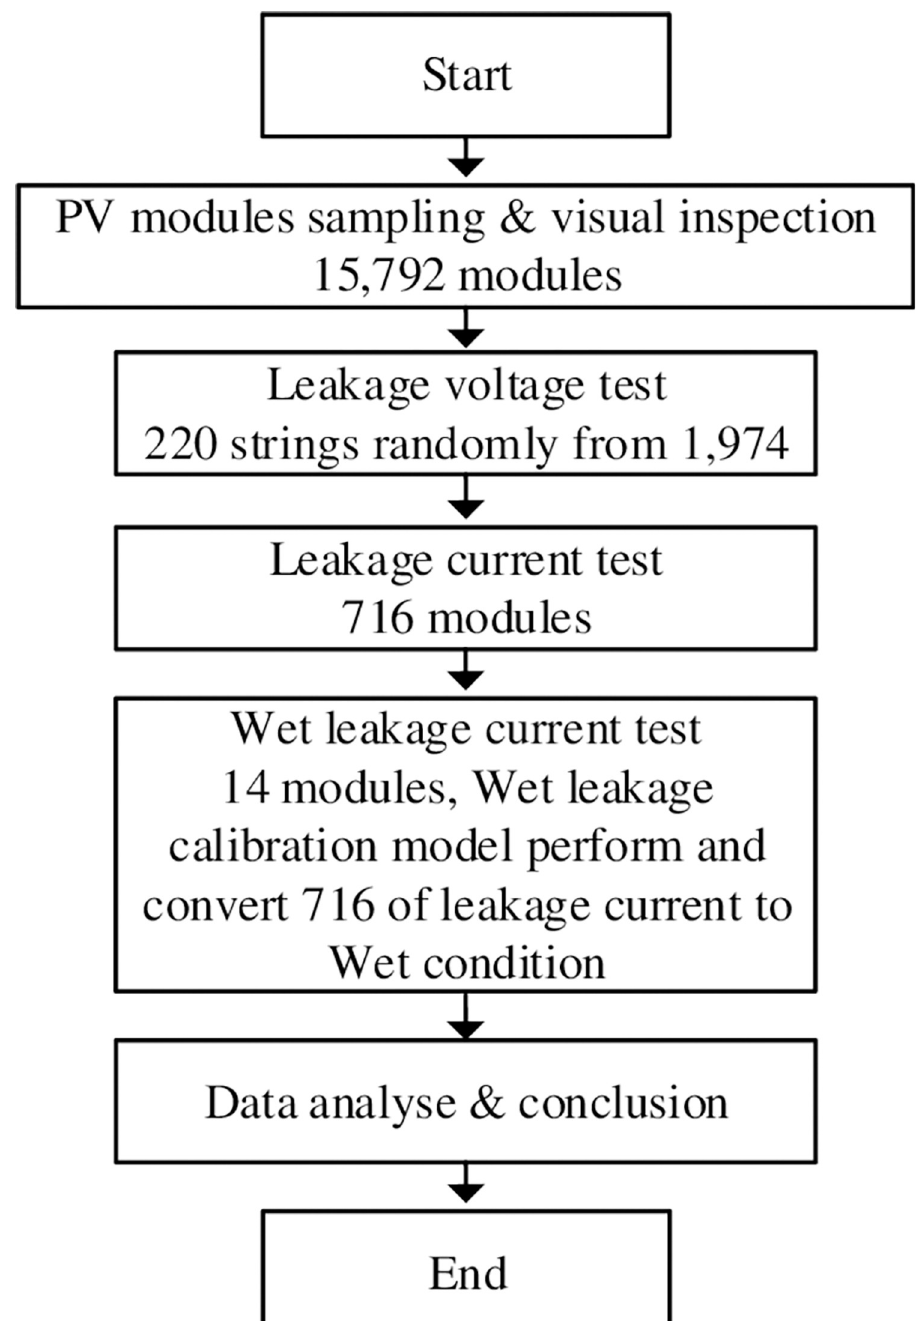
Fig 4. Testing procedure and number of samplings of each